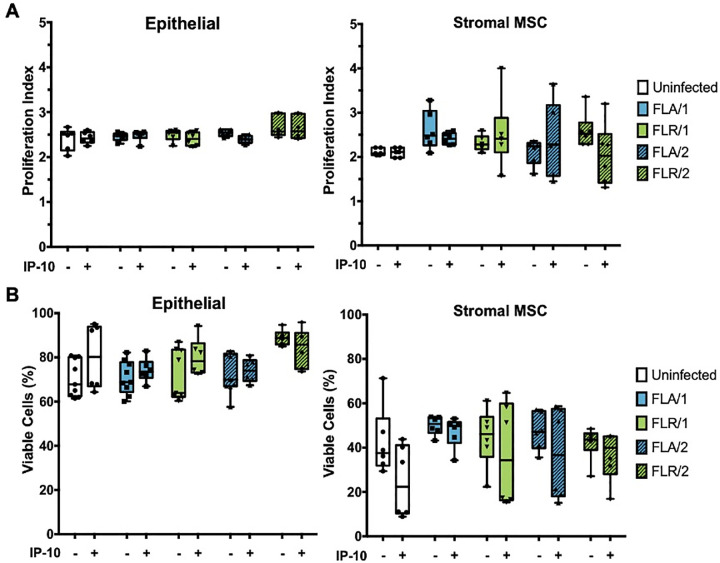
IP-10 treatment does not alter prostate cell proliferation or viability during ZIKV infection.Cells were stained with CellTrace Violet prior to infection with ZIKV isolates. Proliferation index indicates the cell divisions of PNT1a or MSCs after 7 dpi (A). Cells were infected with ZIKV and assessed for viability by flow cytometry at 7 dpi (B). Number of cell types used to propagate virus are indicated numerically after ZIKV isolate names. Data are presented as averages from 2 independent experiments with 3 technical replicates each. Error bars are SEM. Statistical significance was determined using one-way ANOVA followed by multiple comparison t-tests using Tukey correction. ns = not significant.